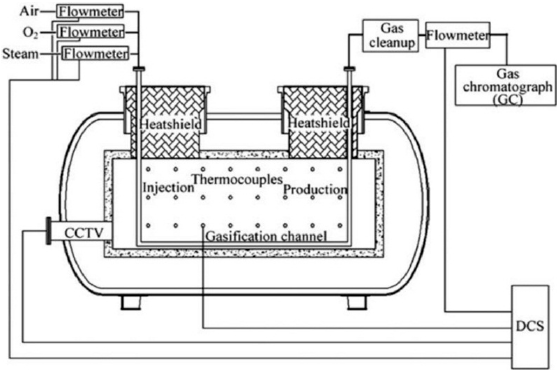
Table 3. Coal ash fusibility